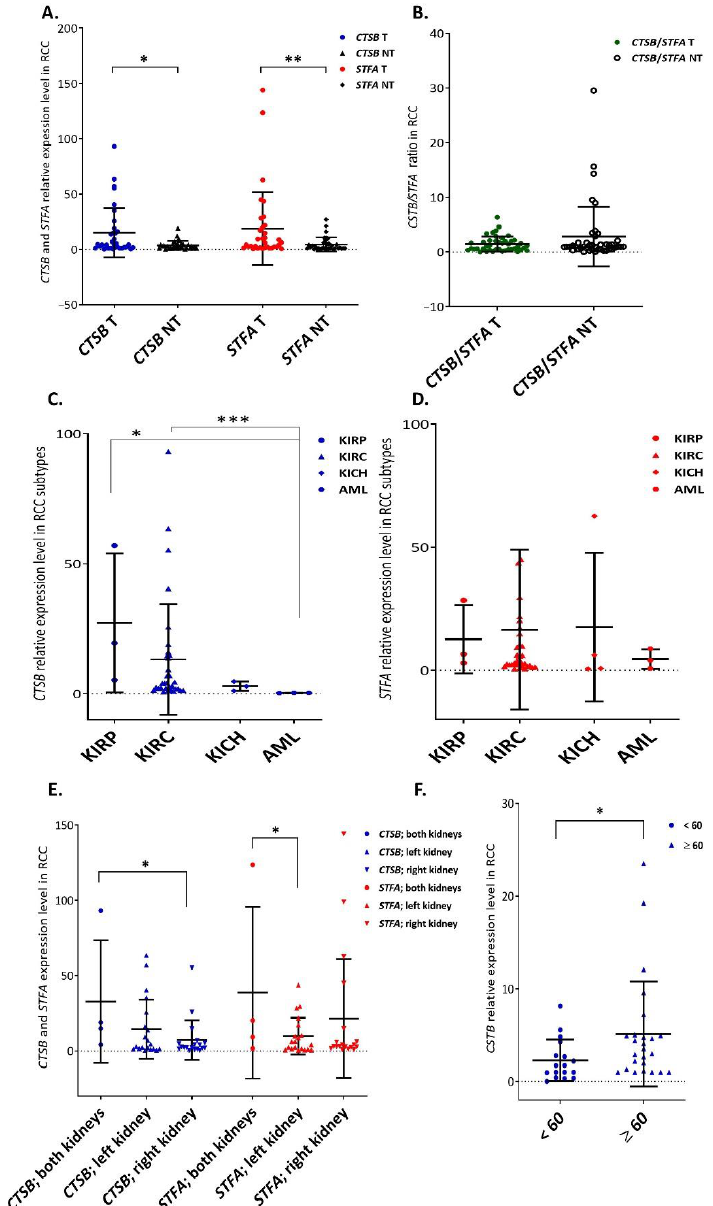
Figure 1. CTSB and STFA mRNA expression in human renal cell carcinoma and surrounding non-tumoral tissue. ( A ) CTSB and STFA were significantly (Student’s test, CTSB , p = 0.012; STFA , U Mann – Whitney test, p = 0.007) increased in tumor tissues; ( B ) CTSB / STFA ratio was lower in tumors than in healthy kidneys ( p > 0.05); CTSB/STFA represents CTSB expression/STFA expression in the same tissue, tumor (T) or non-tumor sample (NT); ( C ) CTSB mRNA expression was significantly higher in papillary cell renal (KIRP) and clear cell renal cell (KIRC) carcinomas compared to renal angiomyolipoma (AML; Kruskal–Wallis test, p = 0.03, p = 0.009, respectively); ( D ) STFA did not increase significantly in KIRP, KIRC, and KICH compared to AML ( p > 0.05); ( E ) in both kidneys CTSB and STFA were significantly (UMann-Whitney test, CTSB , p = 0.027 and STFA , p = 0.036) up-regulated compared to tumors occurring only in right or left kidney, respectively; ( F ) CTSB mRNA expression increased in surrounding non-cancerous kidney tissues of elders (U Mann–Whitney test, p = 0.0268). Results represent the mean ± SD. * = p < 0.05, ** = p < 0.01, *** = p <